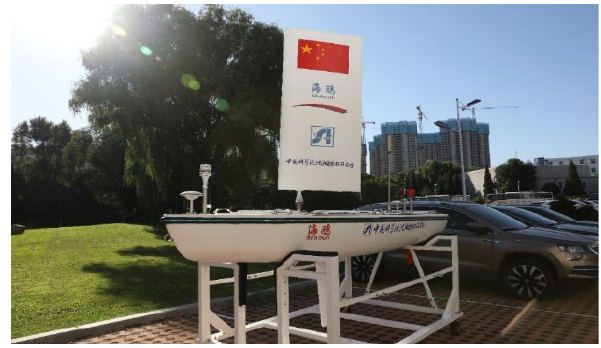
Figure 8. The ‘Seagull’